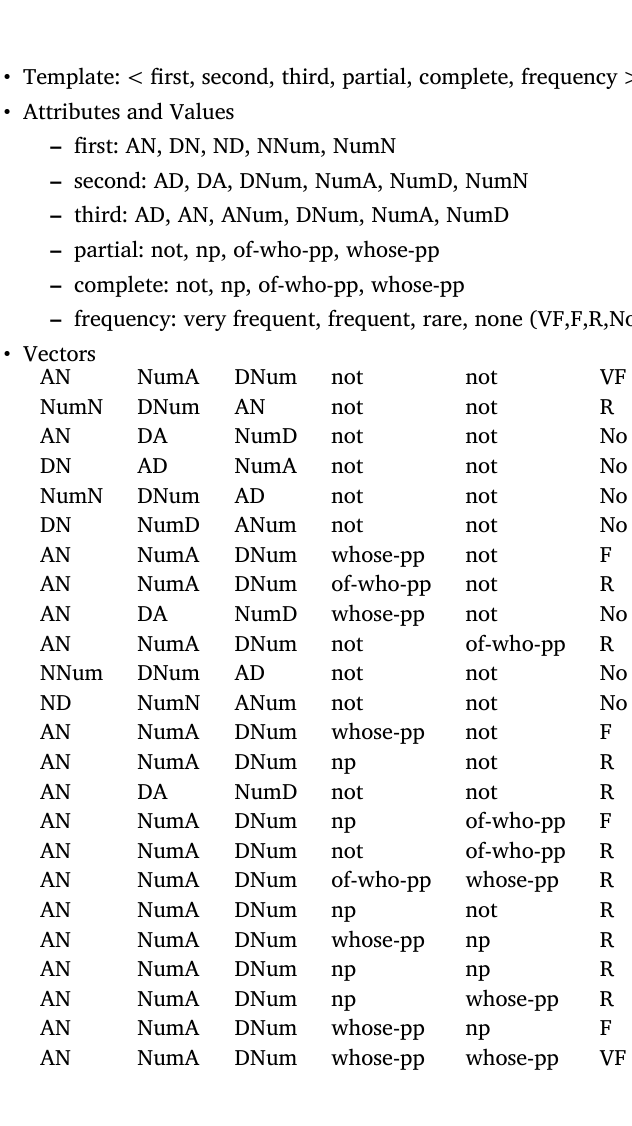
Figure 2: Cinque’s move and merge feature vectors. (See the text for